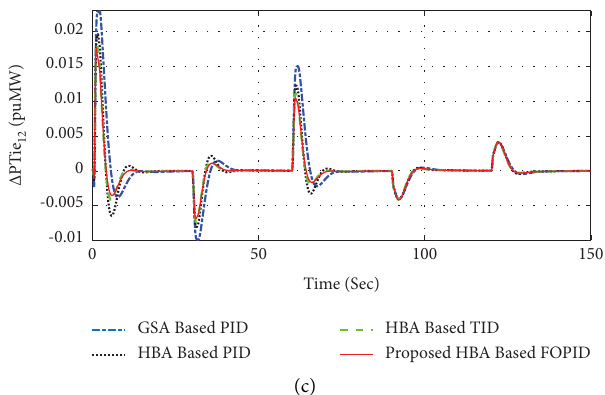
Figure 8: (a–c) System response for sensitivity analysis. (a) A